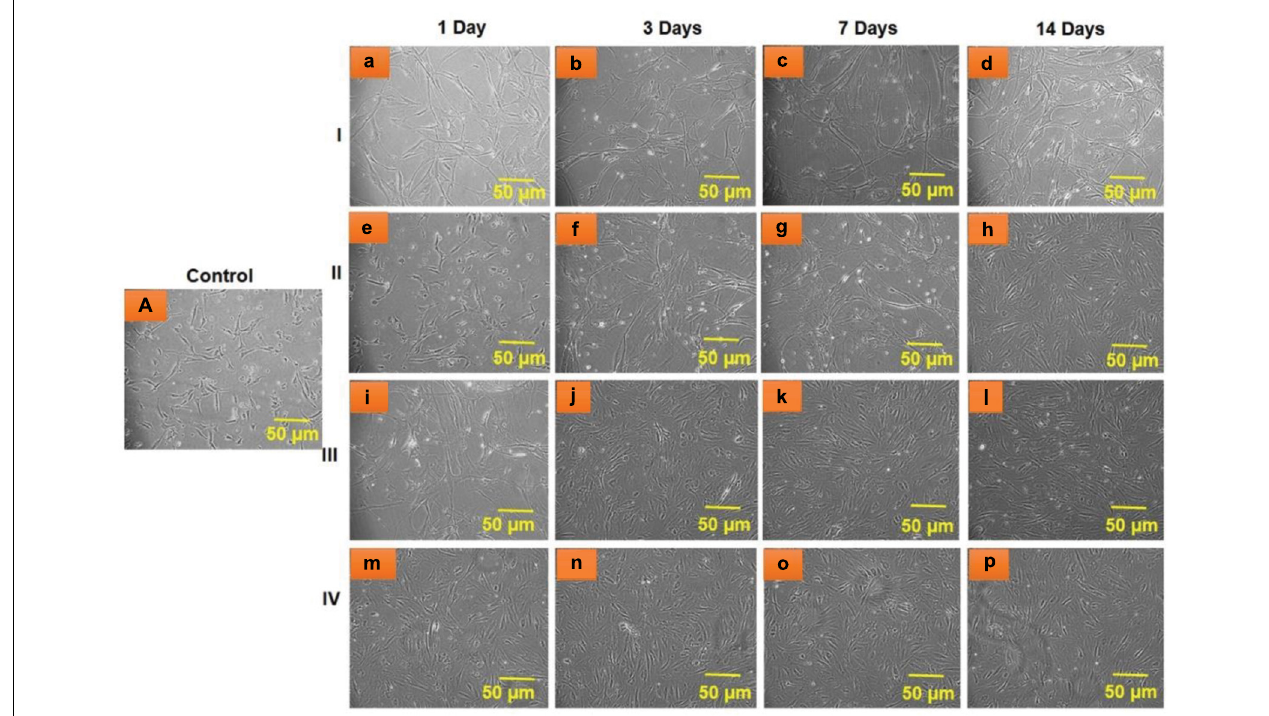
FIGURE 6 | Optical microscopic images of hBMSC viability after treatment with (I) HA (a–d) , (II) BM-HA (e–h) , (III) BM-HA/PAA (i–l) , and (IV) BM-HA/PAA/UMB (m–p) for various days, such as 1, 3, 7, and 14 days. (A) Untreated control cells.